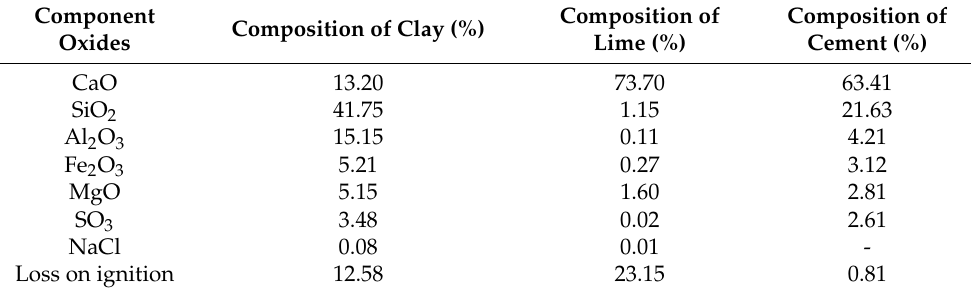
Table 2. Oxide compositions of the